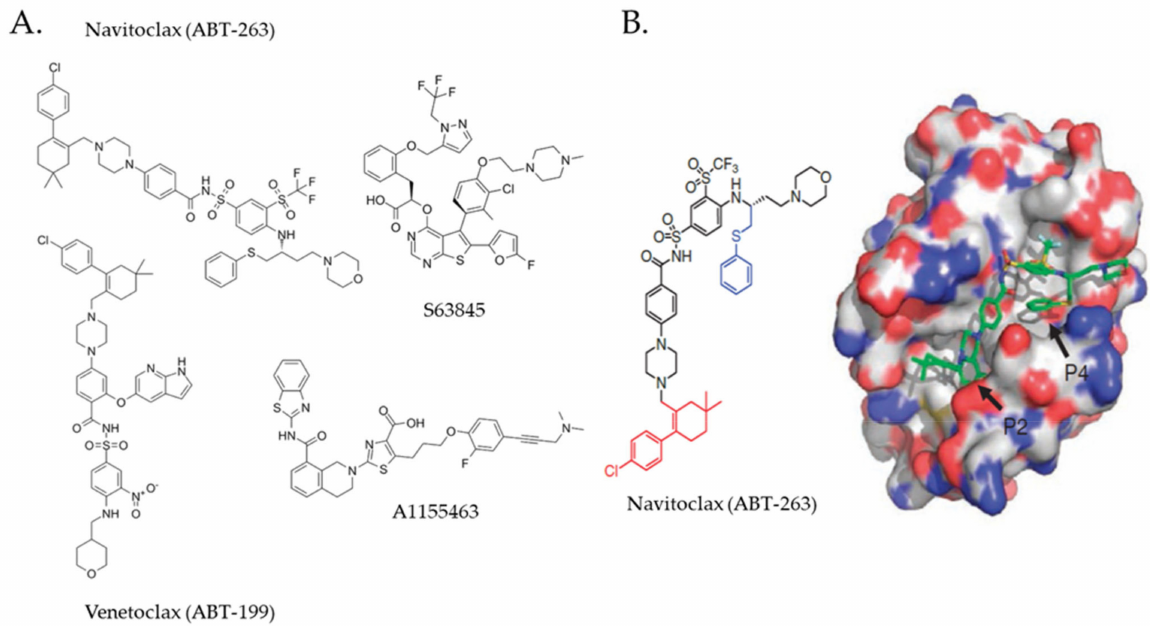
Figure 2. Selected BH3 mimetics targeting the anti-apoptotic BCL2 family proteins. ( A ) Molecular formulas of representative BH3 mimetics binding to/blocking BCL2/BCL-XL (navitoclax), BCL2 (venetoclax), MCL1 (S63845), or BCL-XL (A1155463); ( B ) Graphical representation of navitoclax and its binding to the hydrophobic groove of BCL2 protein (P2, P4—navitoclax- binding BCL2 hydrophobic pockets). Reproduced from [65] with permission from Springer Nature publishing